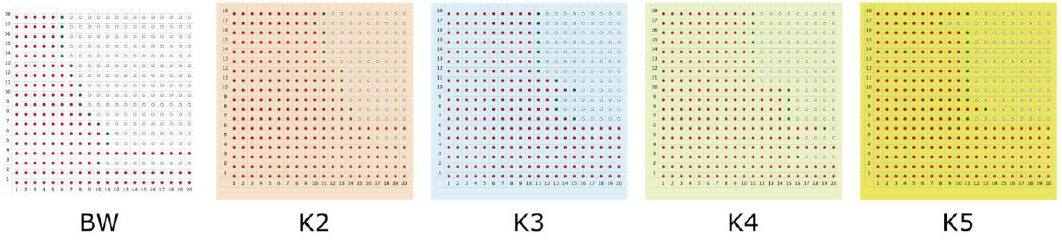
Figure 8. Sample responses in a single respondent survey.